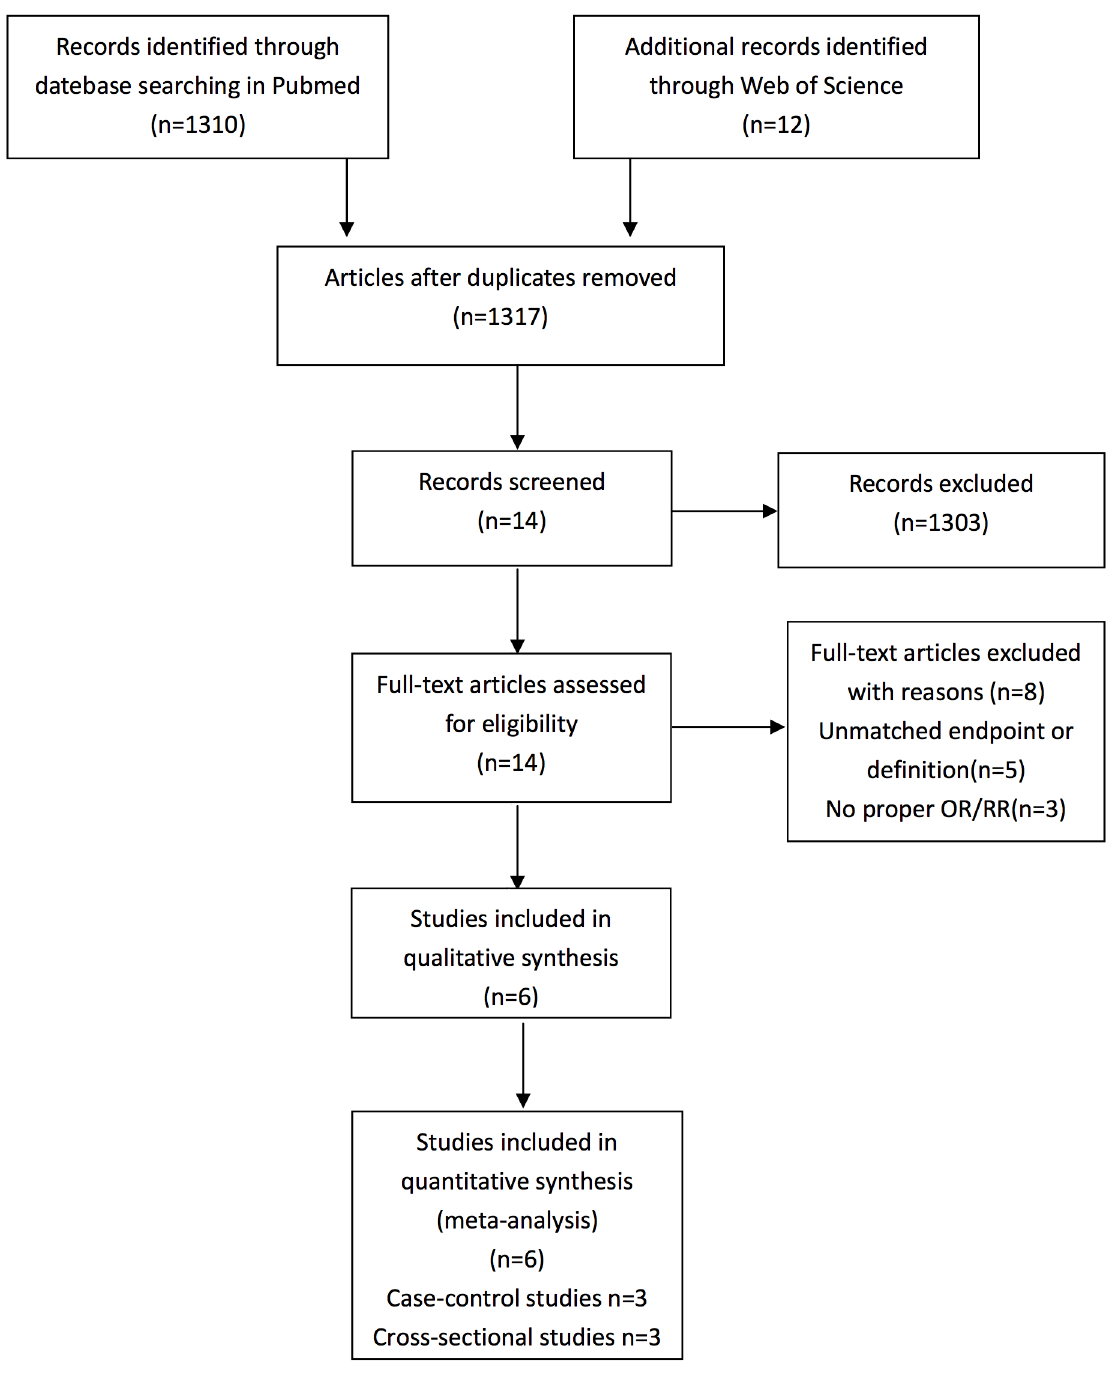
Fig 1. Flow diagram of the literature search in this